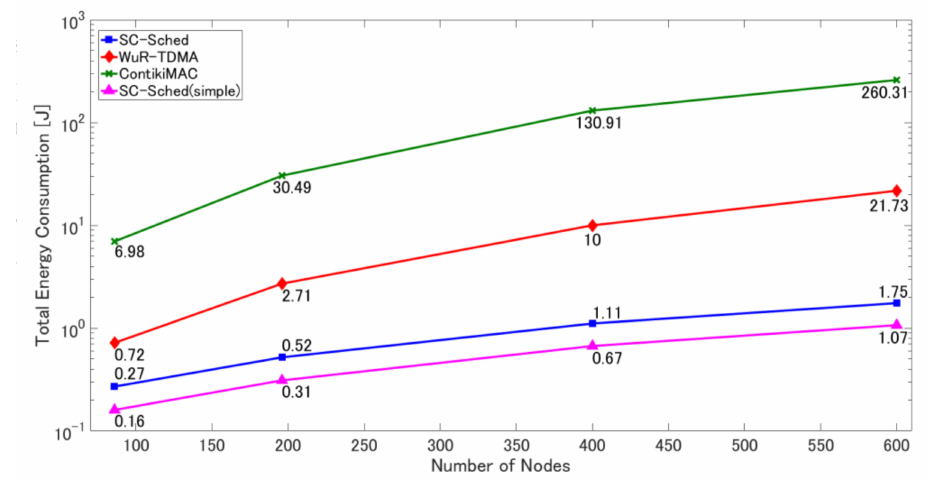
Figure 8. Total energy consumption in the four methods under different numbers of sensor